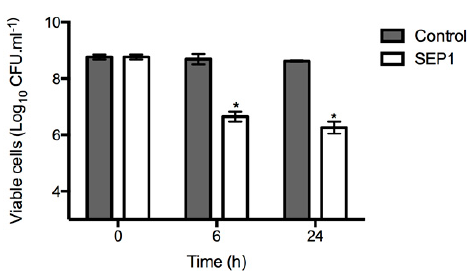
Figure 3. SEP1 phage infection of 24 h S. epidermidis 9142 disrupted biofilms, using a MOI 1. Data was assessed by CFU counting and the values represent the mean plus and minus of three independent experiments performed in duplicate. Statistical differences ( p < 0.001) between control biofilms and SEP1-treated biofilms (*) were determined by two-way repeated-measures analysis of variance (ANOVA) with Bonferroni post hoc test.